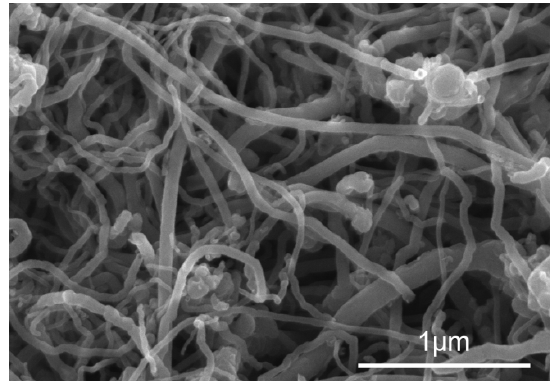
Figure 2. SEM image of the as-received MWCNTs with diameter of 60–100